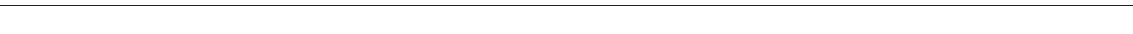
Fig. 5 Differentially active pathways across pan-urologic genomic subtypes. a Across the genomic subtypes, heat map represents differential aggregate expression of mRNAs associated with metabolism pathways, along with expression of metabolism-related proteins (using values normalized within cancer type; gray , no data; GNG , gluconeogenesis). Pathway diagram represents core metabolic pathways, with differential expression patterns comparing tumors in groups c5, c8, or TGCT.c9 (subset c9 of TGCT type) with tumors in groups RCC.c6 (c6 of KIRC or KICH type), c1, or TGCT.c4, respectively ( red , signi fi cantly higher in c5/c8/TGCT.c9). b Across the genomic subtypes, heat map represents differential aggregate expression of mRNAs associated with hypoxia, EMT, MAPK, NRF2-ARE, and cyclin D1 pathways, along with a proteomic MAPK signature (using values normalized within cancer type). Pathway diagrams represent relationships between the above pathways 23 – 26, 53, 54 , with differential expression patterns comparing tumors in groups c5, c8, or c9 with tumors in groups c7, c1, or c2, respectively ( red , signi fi cantly higher in c5/c8/c9). c Across the genomic subtypes, heat map represents differential mRNA and protein features involved with Hippo pathway. Pathway diagrams represent differential expression patterns comparing tumors in groups c2, c4, or c5 with tumors in groups c9, c9, or c6, respectively ( red , signi fi cantly higher in c2/c4/c5). See also Supplementary Fig.